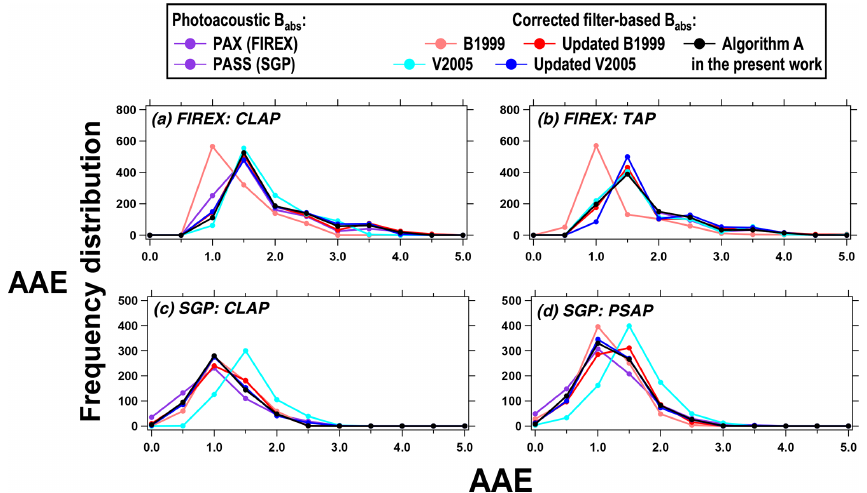
Figure 10. The frequency distribution of AAE calculated for different instrument–correction combinations of multiwavelength B abs